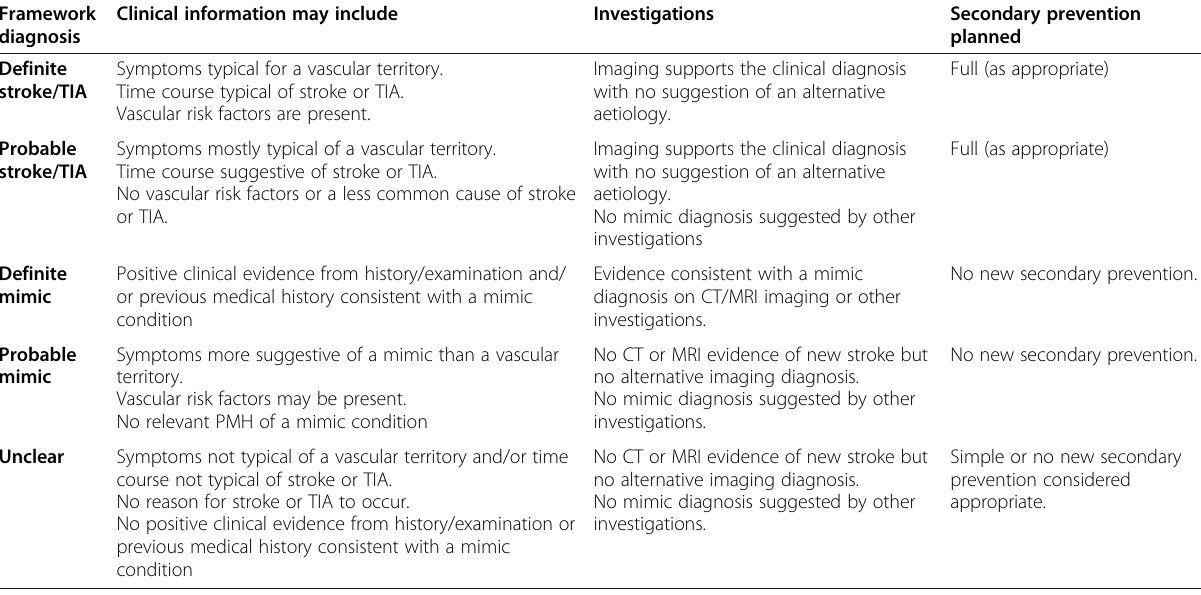
Table 2 Guidance for completion of the primary diagnosis framework Framework